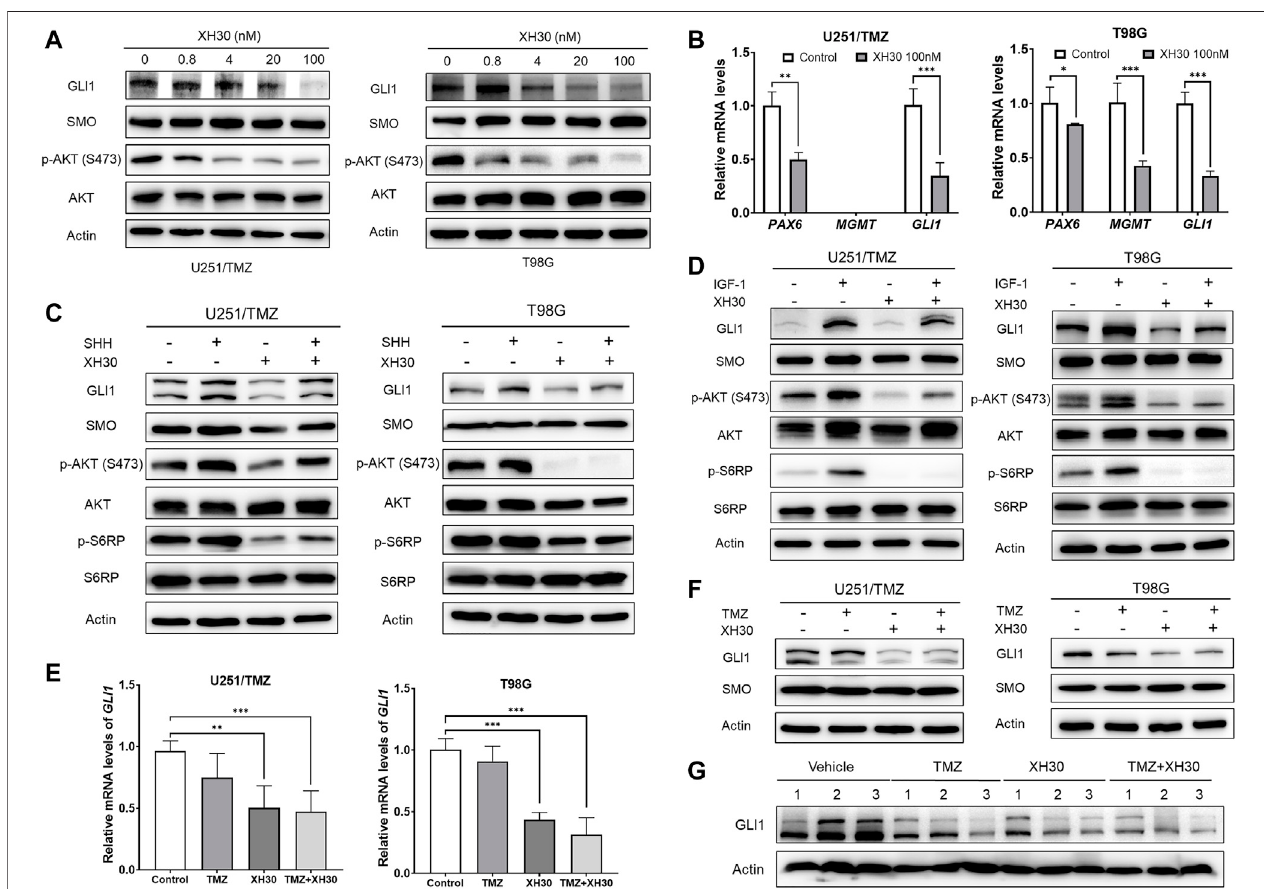
FIGURE 6 | XH30 suppressed GLI1 via blockade of the noncanonical hedgehog signal pathway. (A) XH30 dose-dependently reduced GLI1 protein levels in TMZ- resistantU251/TMZandT98Gcells.CellswereincubatedwithXH30atindicatedconcentrations(0.8,4,20,and100 nmol/L)for12 h (B) XH30downregulatedtheGLI1 target gene expression, as indicated by mRNA levels, in both U251/TMZ and T98G cells. Data are presented as means ± SD, n (cid:1) 3. t -test, * p < 0.05, ** p < 0.01, and *** p < 0.001, compared with control. (C) XH30 attenuated SHH-triggered GLI1 activation in U251/TMZ and T98G cells. The cells were incubated with XH30 at a concentrationof100 nMintheabsenceorpresenceofrecombinantSHH(500 ng/ml)for24 h. (D) XH30reversedGLI1activationbyIGF-1inU251/TMZandT98Gcells. Cells were incubated with XH30 at a concentration of 100 nM in the absence or presence of recombinant IGF-1 (50 ng/ml) for 12 h. (E) XH30 and TMZ in combination maintained lower mRNA levels of GLI1 in GBM cells. The cells were incubated with XH30 (100 nM) or TMZ (250 μ M) for 12 h. t -test, ** p < 0.01 and *** p < 0.001, compared with control. (F) XH30 and TMZ in combination maintained lower protein levels of GLI1 in GBM cells. The cells were incubated with XH30 (100 nM) or TMZ (250 μ M) for 12 h. (G) Protein levels of GLI1 in tumor tissue from the U251/TMZ xenograft mice model.